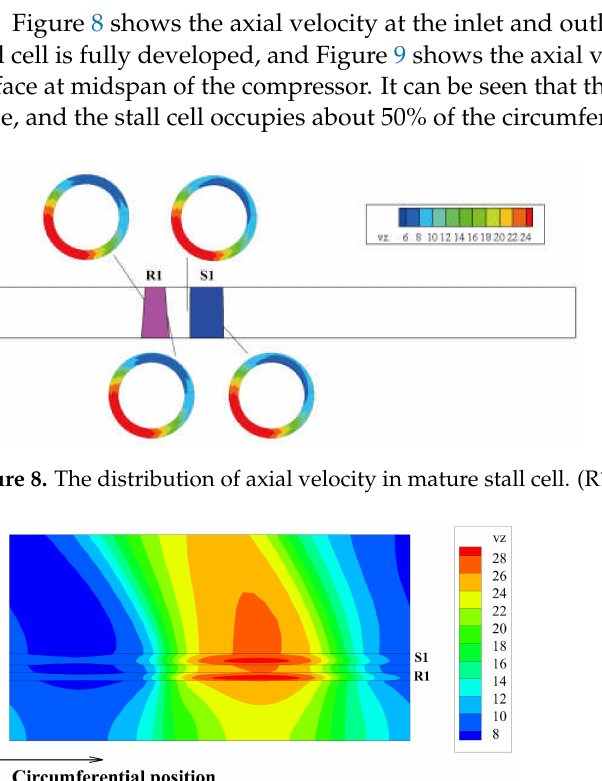
Figure 7. Traces of static pressure in the tip region of compressor inlet at different circumferential loca- tions, ( a ) calculated, ( b ) experimental. The red dashed line represents the circumferential propagation, from which the rotational speed of the stall cell can be calculated.